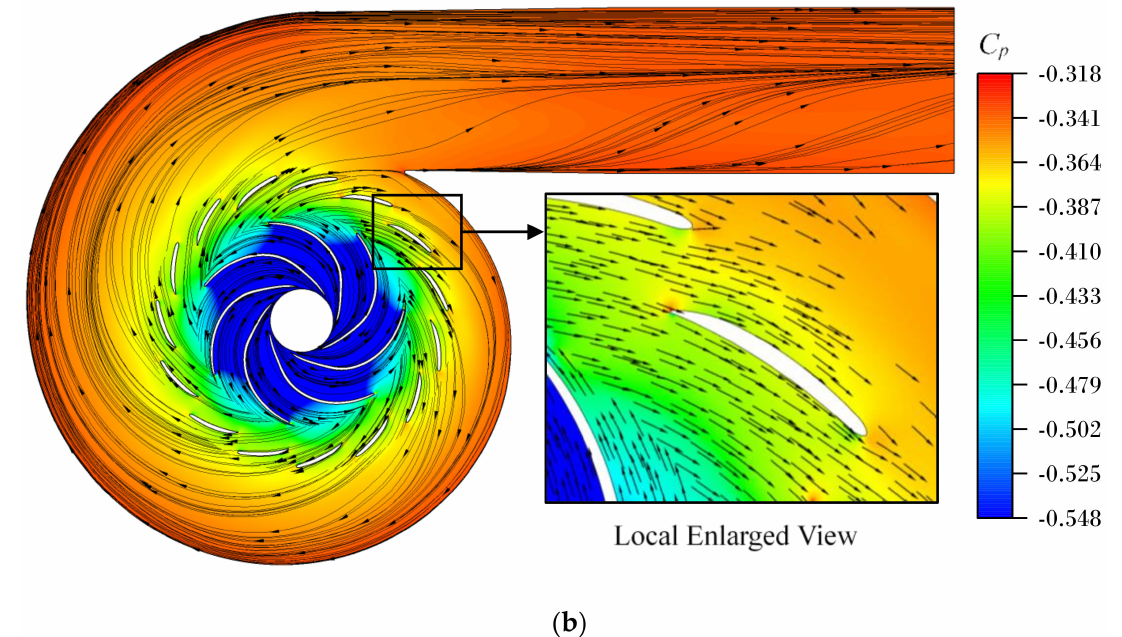
Figure 11. Flow pattern overview in the pump at ϕ d on Z = 0 plane and impeller mid-span surface. ( a ) Indication of Z = 0 plane and impeller mid-span surface; ( b ) pressure contour and velocity